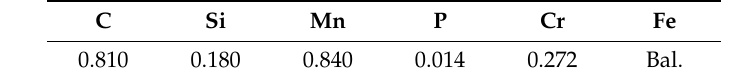
Table 1. Chemical composition of the cold drawn pearlitic steel wires used in this study (wt %). C Si Mn P Cr Fe 0.810 0.180 0.840 0.014 0.272